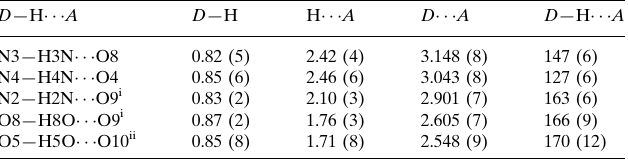
Hydrogen-bond geometry (A˚ , (cid:2)